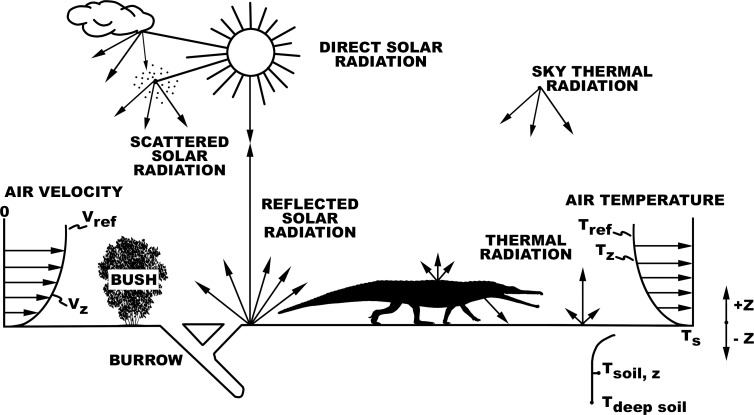
Organism-environment heat balance interactions.The reptile’s heat and mass balances that influence body temperature are determined by where it chooses to be each hour to remain within its preferred body temperature range. Niche Mapper allows it to find a location each hour where it can remain active, or not, if necessary, to optimize its body temperature and/or water balance.